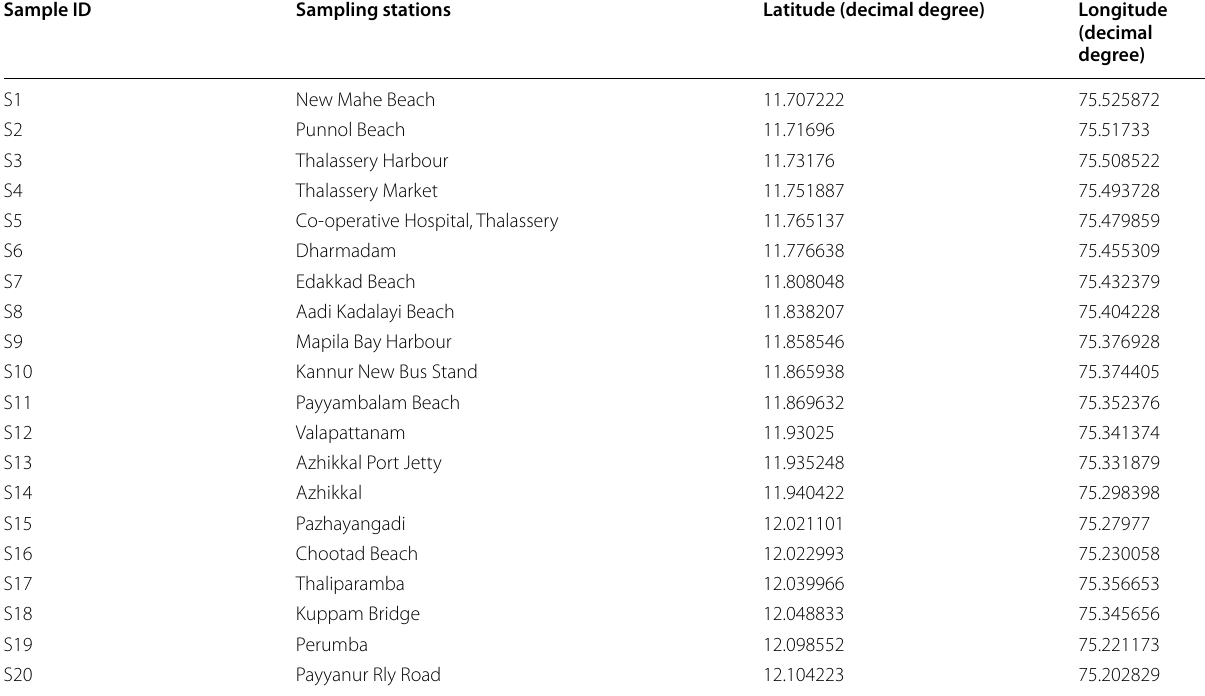
Table 1 The latitude and longitude of the sampling stations